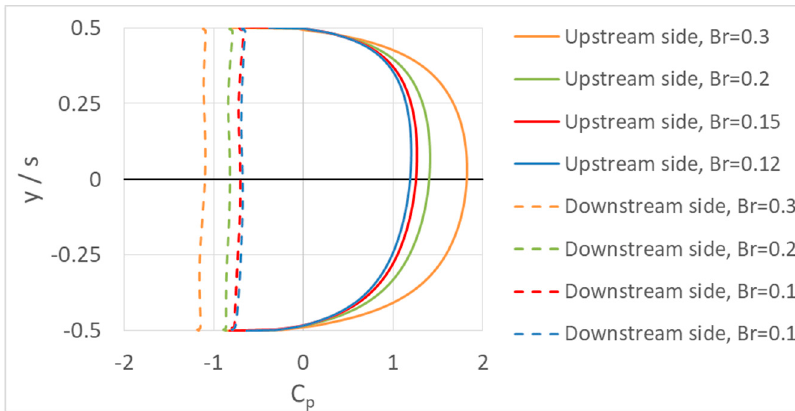
Figure 22. Drag coefficient ( left ) and lift coefficient ( right ) versus the blockage ratio. Based on the two scenarios of undisturbed upstream velocity and local velocity (dotted lines). h* = 2.